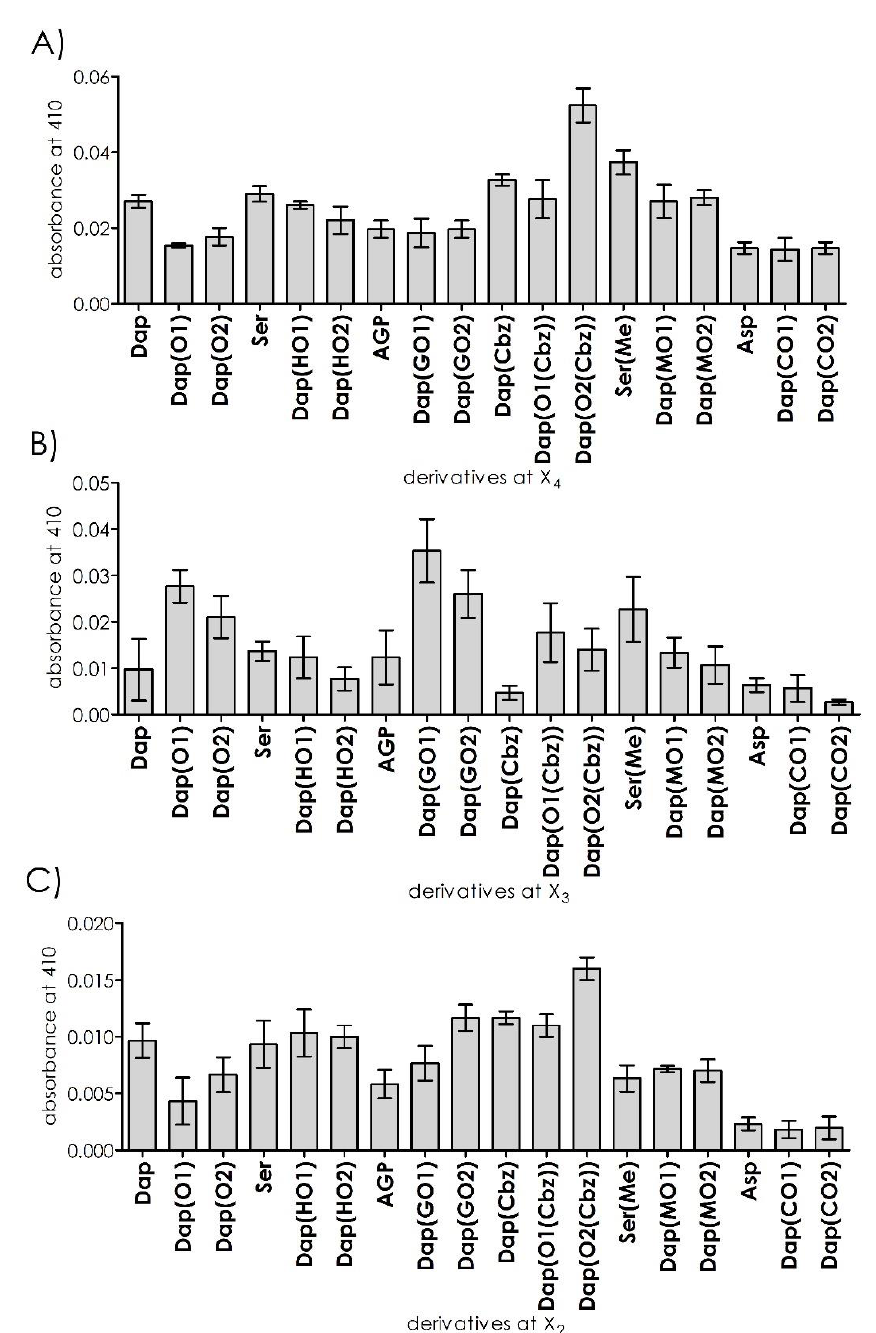
Figure 2. Deconvolution of the library (at an average concentration of 3.4 × 10 − 6 M) with the general formula ABZ–X4–X3–X2–Arg–ANB–NH 2 against the 20S proteasome (1.46 × 10 − 9 M). ( A ) Cleavage rates of individual sublibraries recorded for position X4; ( B ) Cleavage rates of individual sublibraries recorded for position X3; ( C ) Cleavage rates of individual compounds modified in position X2.